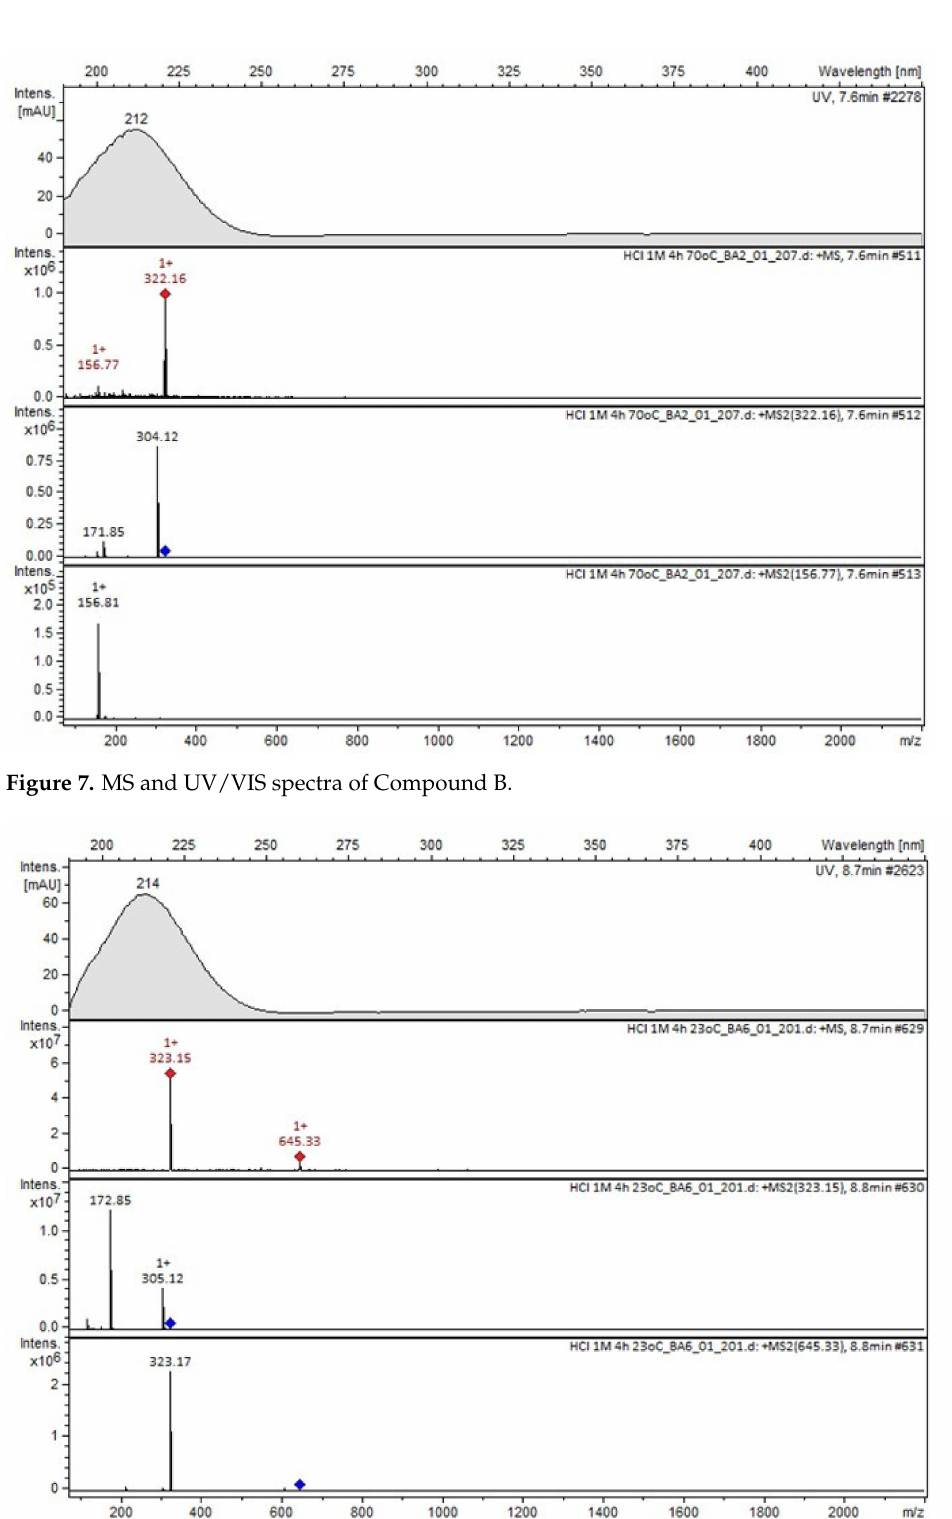
Figure 8. MS and UV/VIS spectra of Compound